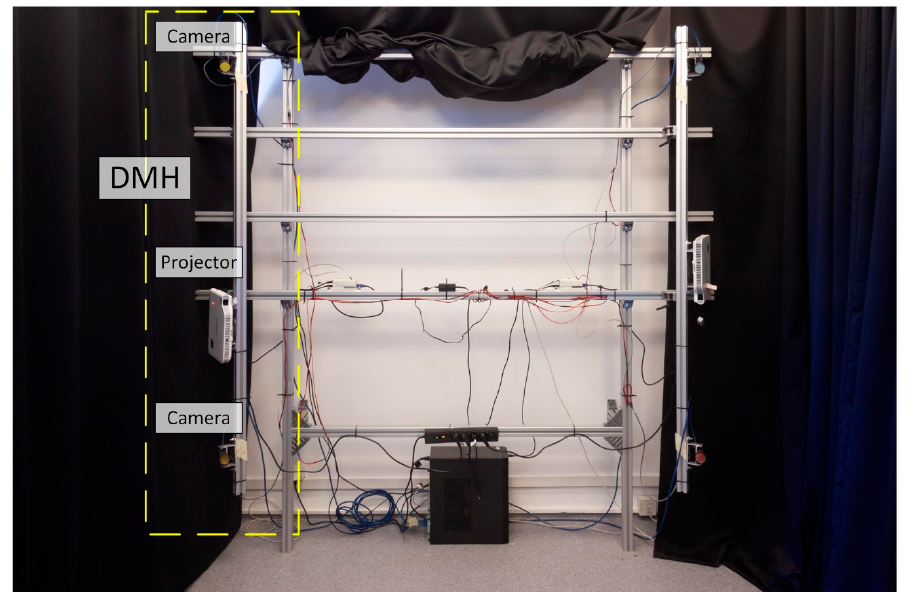
Figure 3. Photograph of the developed 4DBODY system (two directional measurement heads (DMHs) are visible). A single DMH with its constituent devices is enclosed within the dashed rectangle.